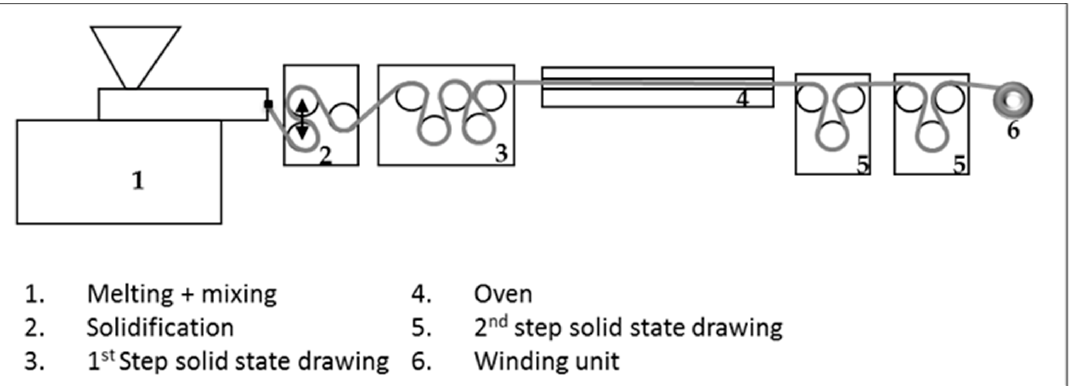
Figure 1. Schematic showing the experimental setup. Table 1. The processing parameters used in the different processing steps.